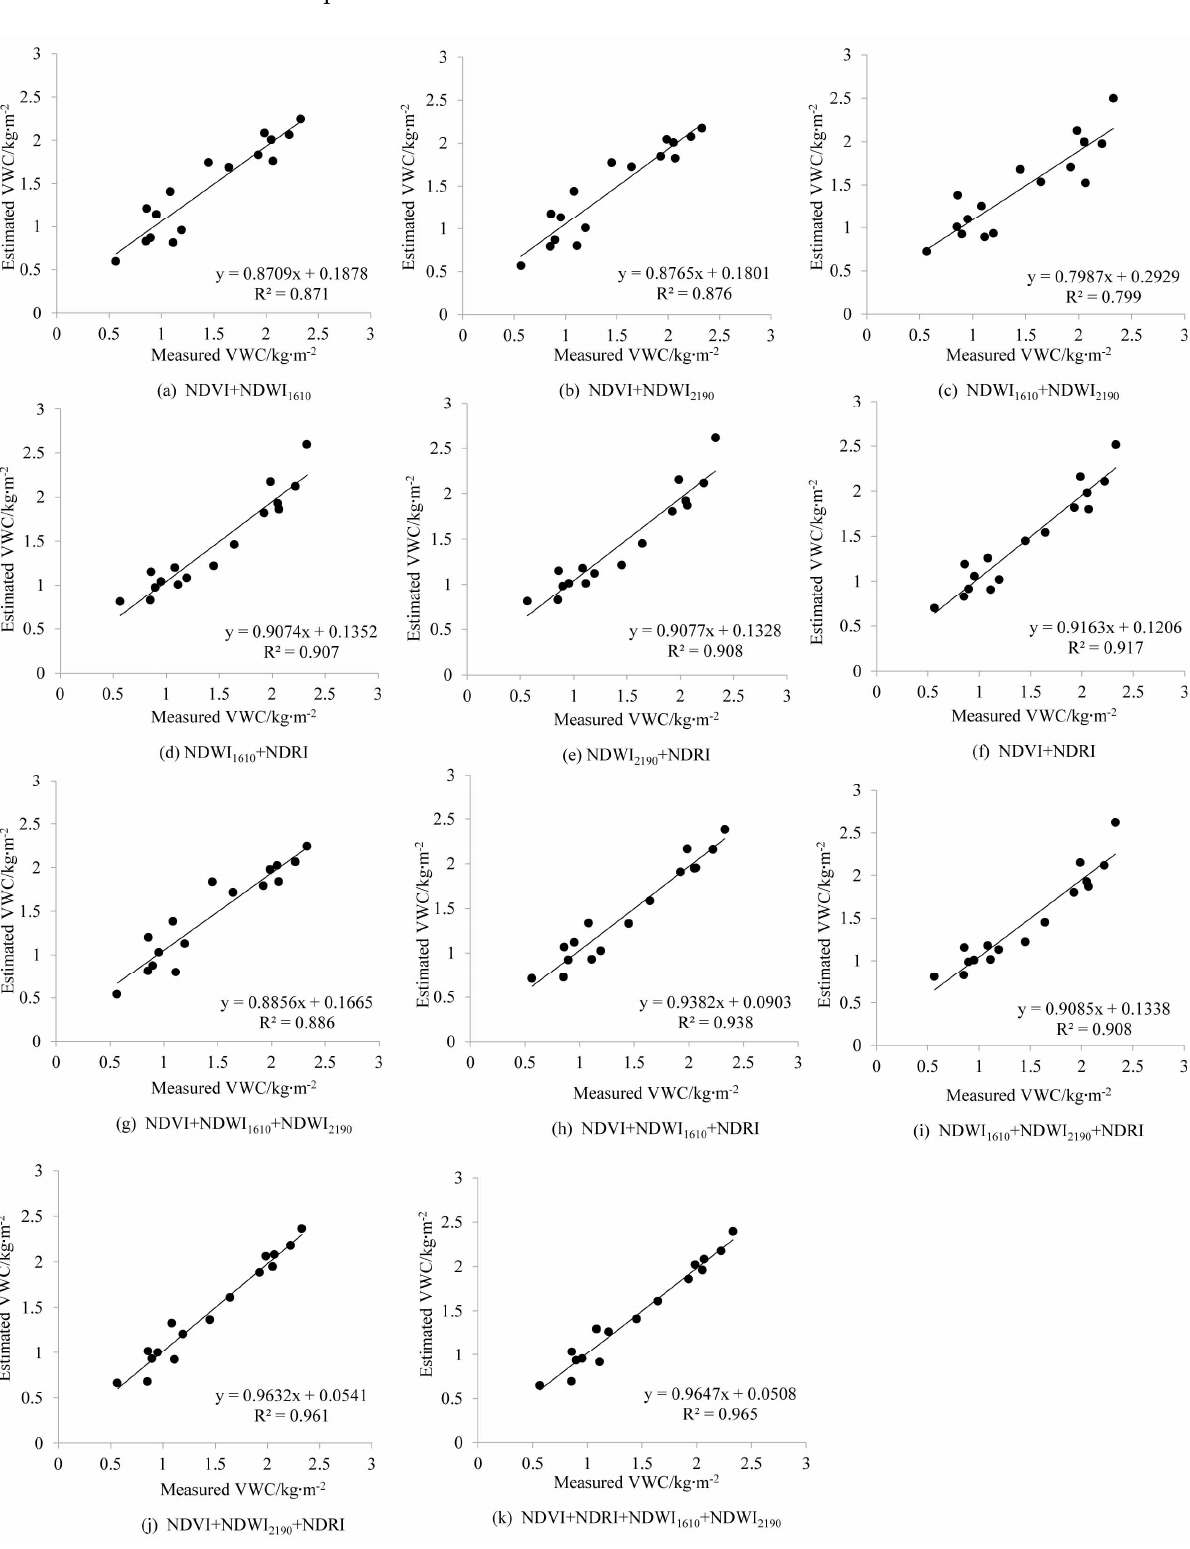
Figure 4. Scatter plots of measured and estimated VWC, using combinations of vegetation indices. Table 2. Correlations between the modified VWC estimation models and the in situ measured VWC data.